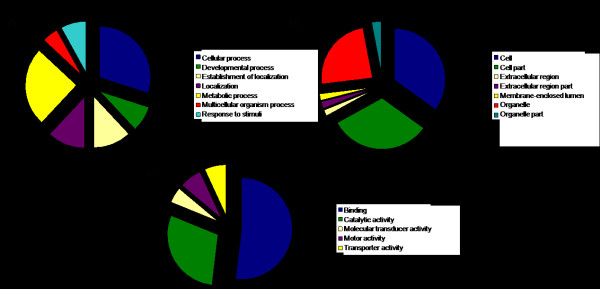
Gene classification based on Gene Ontology. A) Biological process. B) Cellular component. C) Molecular function.